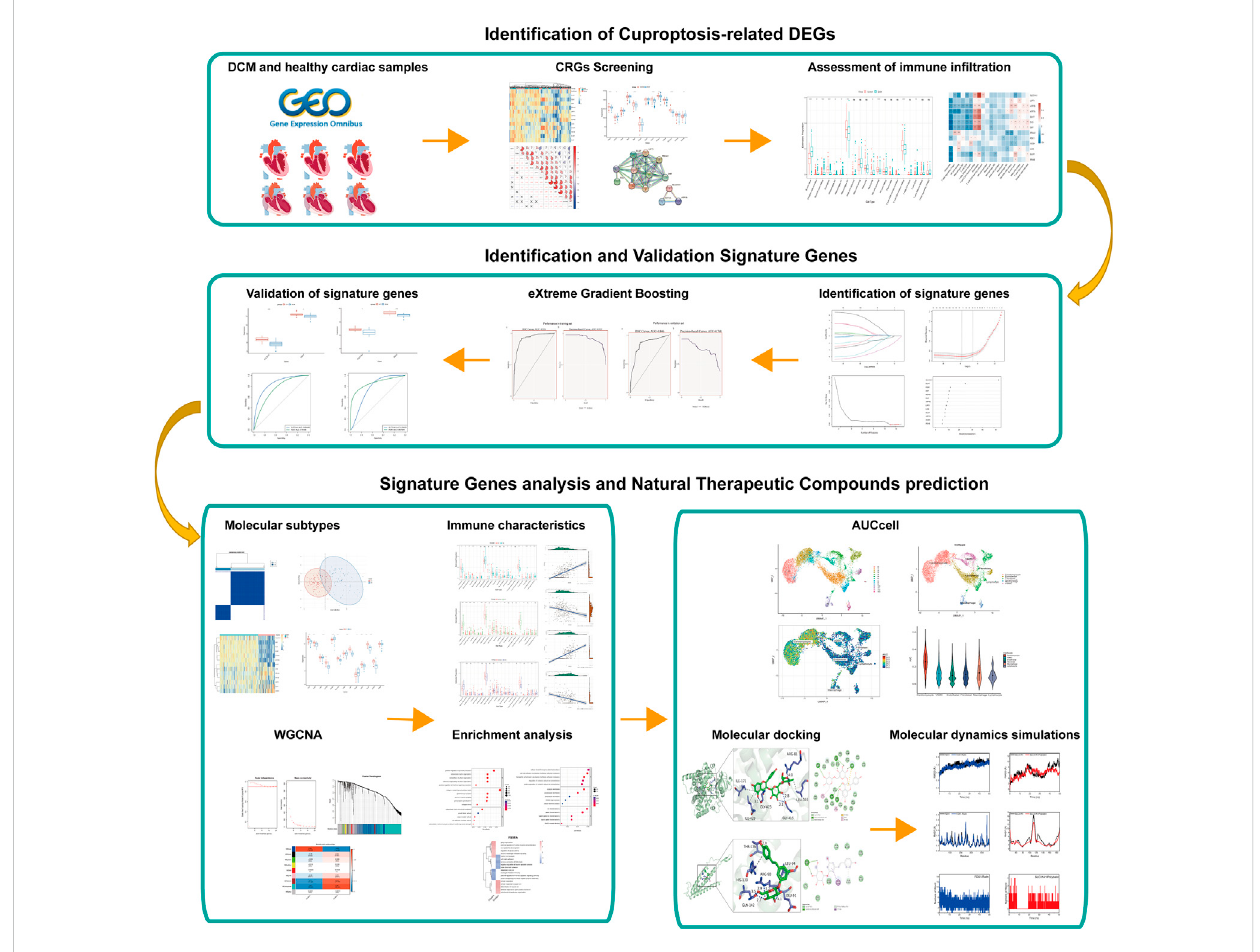
FIGURE 1 The fl owchart of analysis